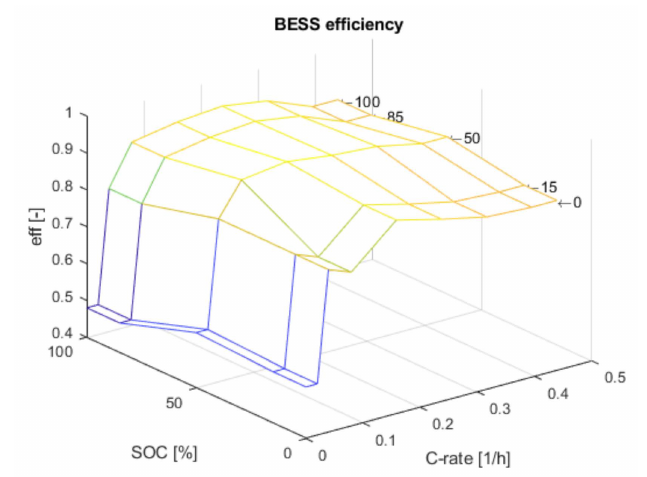
Figure 9. The control surface of the BESS efficiency.